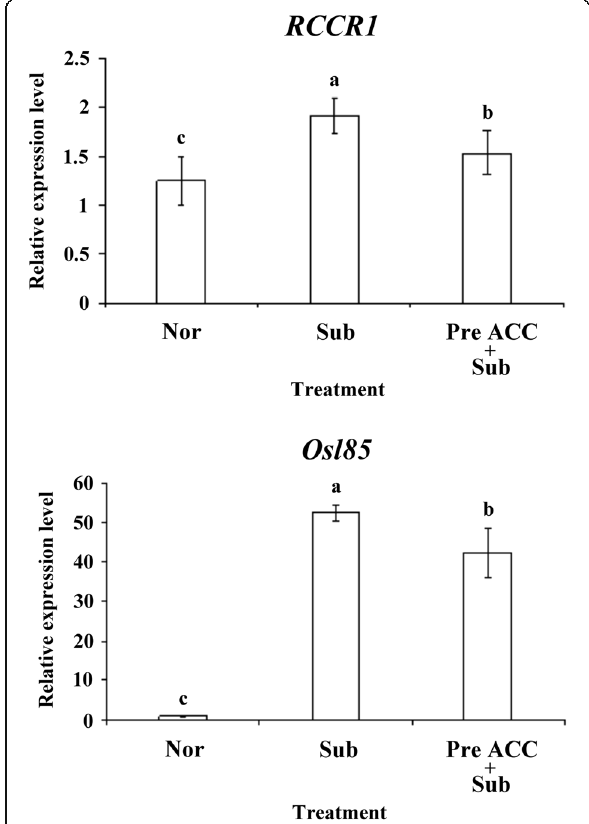
Fig. 4 The transcript levels of SAGs in rice seedlings by pretreatment with an ethylene precursor under submergence conditions. qRT-PCR quantified the transcript levels of RCCR1 and Osl85 genes in 8-day- old TK9 rice seedlings treated under Nor, Sub, and Pre ACC + Sub for 2 days and then subjected to submergence for 4 days. The data represent the average values ± SD from three biologically independent experiments. The values with different letters are significantly different at P < 0.05, according to one-way ANOVA